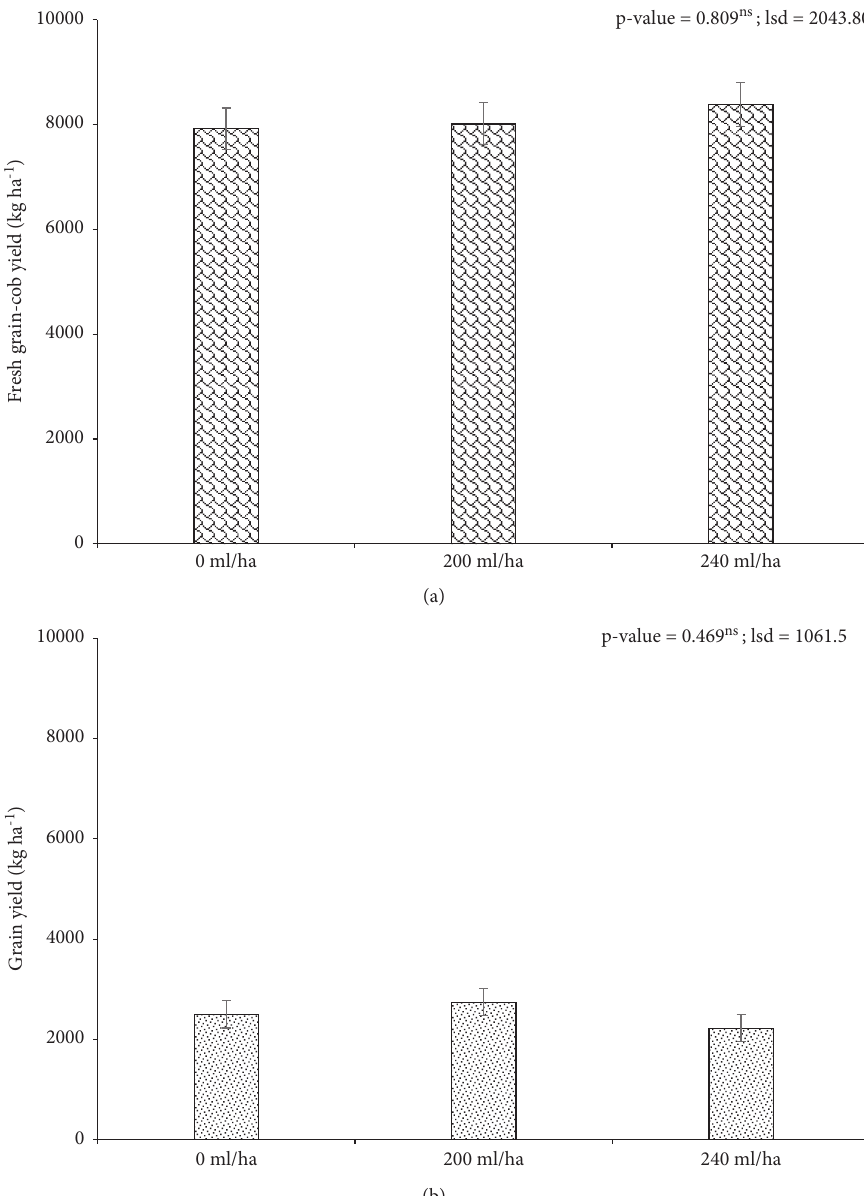
Figure 3: Maize grain yield determined as (a) fresh grain on cob after 70 days of growth and (b) dry grain deshelled from cob at